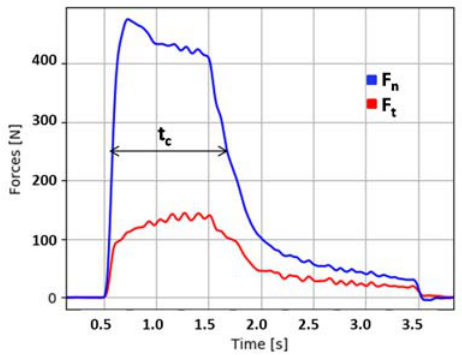
Figure 4. Normal and tangential force signals of test 1a for WFA.